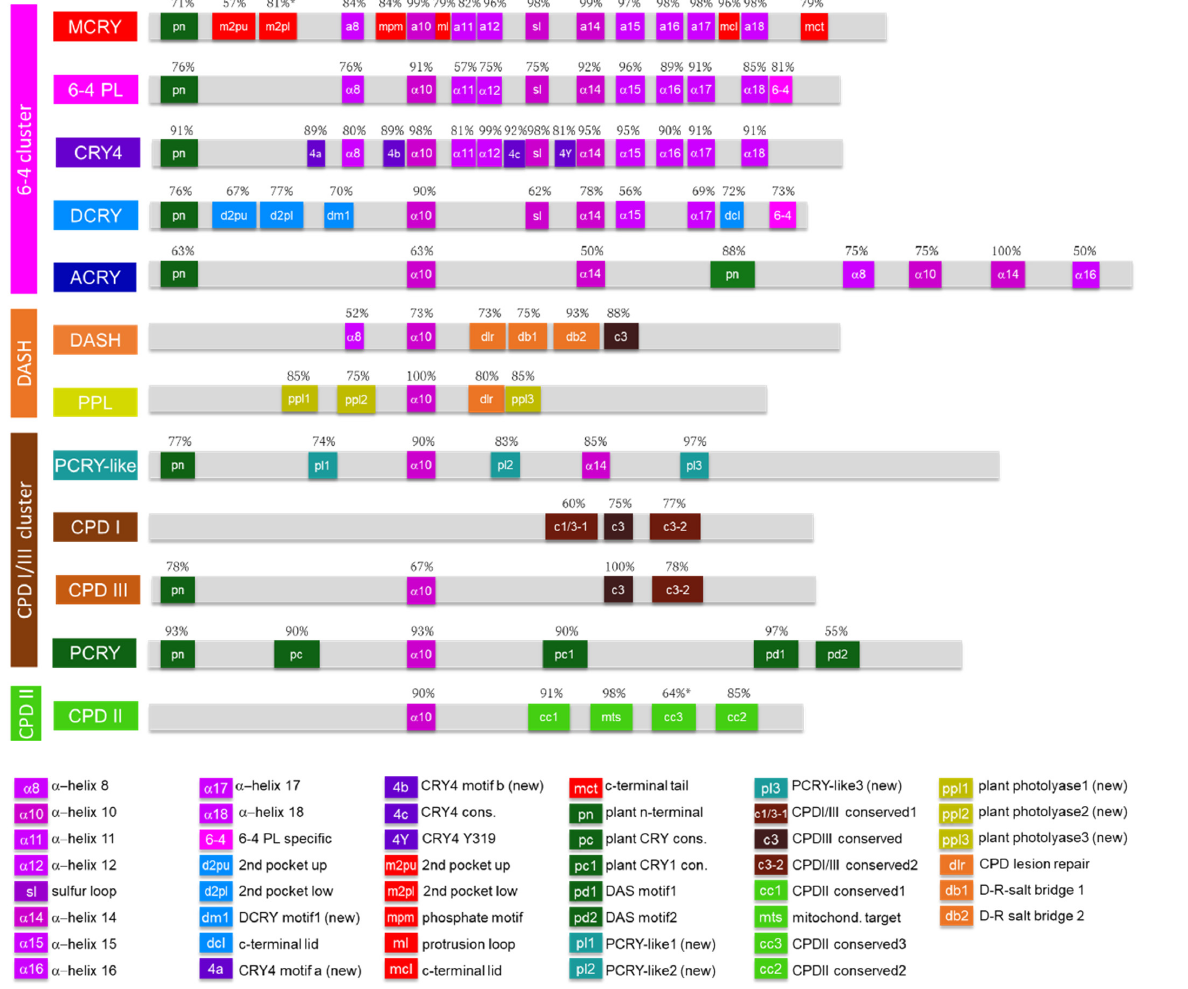
Figure 3. Schematic representation of the CRY/PL subfamilies along with their most frequent motifs. Only motifs that occur with a frequency of at least 50% are shown. A detailed list of all motifs, their sequences and references can be found in Supplementary Materials S4, and protein sequence alignments of all subfamilies can be found in Supplementary Materials S5. In the case of m2pl*, both insect (13%) and non-insect (68%) data were combined, and for cc3*, data from microorganisms & animals (59%) were summed with those from plants (5%).